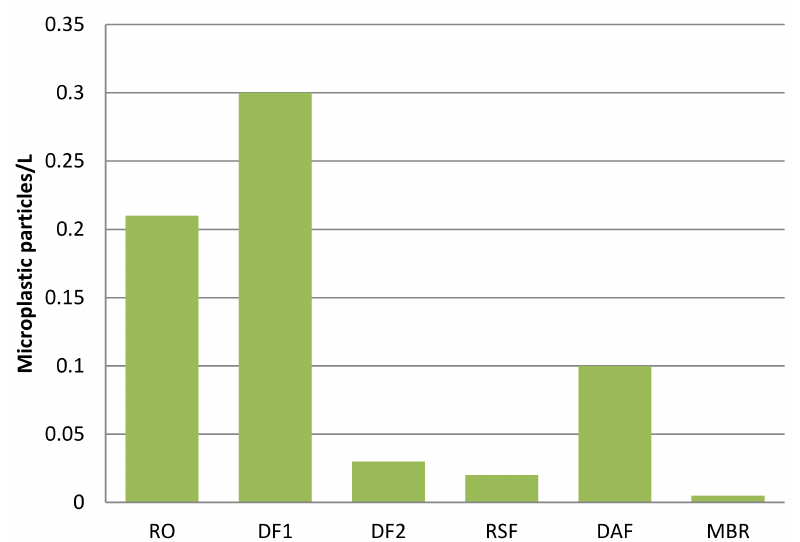
Figure 6. The number of microplastic particles per liter in the final e ffl uent of each wastewater treatment plant (Data elaborated from Ziajahromi et al. 2017 and Talvitie et al. 2017). RO: Reverse Osmosis; DF1: Disc Filter with pore size 10 µ m; DF2: Disc Filter with pore size 20 µ m; RSF: Rapid Sand Filters; DAF: Dissolved Air Flotation; MBR: Membrane